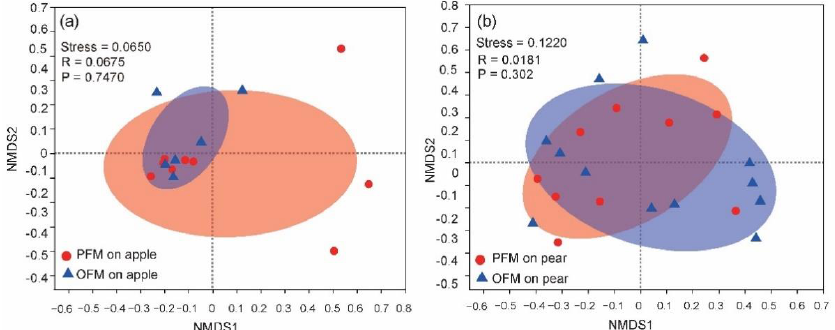
Figure 3. Community diversity ( a ) and richness ( b ) for the OTU level of gut bacterial microbiota between the peach fruit moth (PFM) Carposina sasakii and the oriental fruit moth (OFM) Grapholita molesta . Each bar represents an individual moth. There is significance of the difference between PFM and OFM in diversity and richness in term of Shannon ( a ) and Ace ( b ) index estimated by Kruskal– Wallis test.